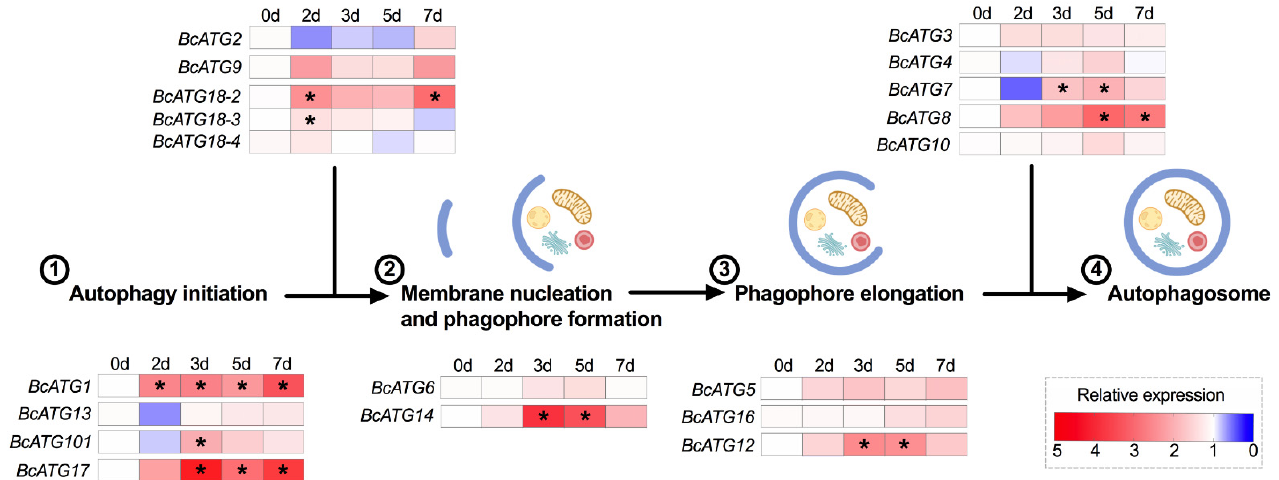
Figure 2. Heat map of gene expression profiles of ATGs upon LsoB infection corresponding to the process of autophagosome formation. 0 d indicates the control, in which psyllids were taken from the Lso ‐ free colony; 2 d, 3 d, 5 d, and 7 d indicate the psyllids were infected by LsoB for 2, 3, 5, and 7 days, respectively (d indicates day). The numbers indicate the steps of autophagosome formation. The asterisks (*) indicate statistical differences compared to control at p < 0.05 using one ‐ way ANOVA with Tukey’s post hoc test.